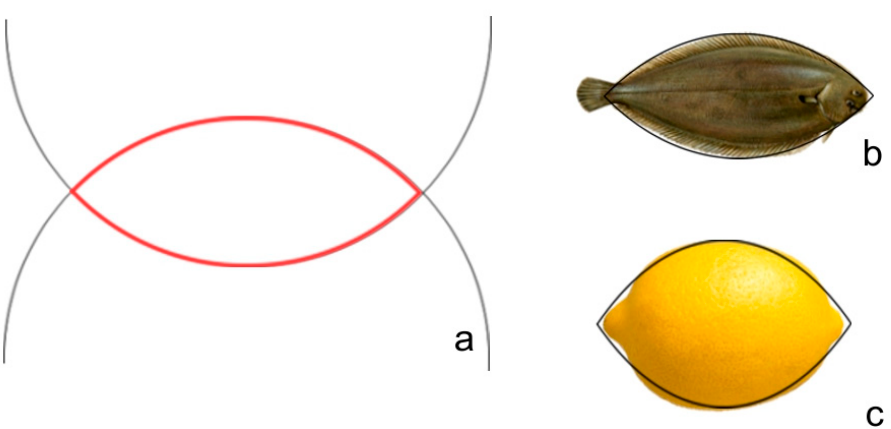
Figure 7. ( a ) The lens is the figure produced by the intersection of two circles. ( b ) Solea solea sp., a fish of the family Soleidaidae. ( c ) A lemon fruit ( Citrus sp. Rutaceae).